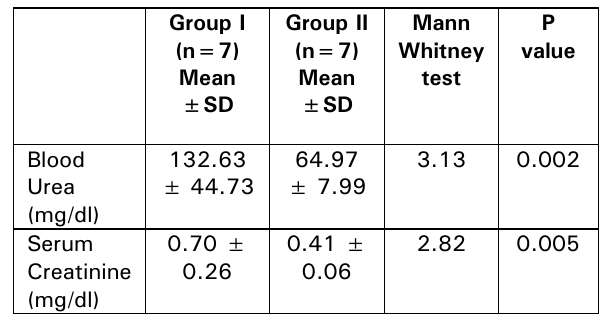
Table1: comparison between day3 renal functions of rats with cisplatin-induced AKI (GroupI) and saline-injected rats (GroupII)